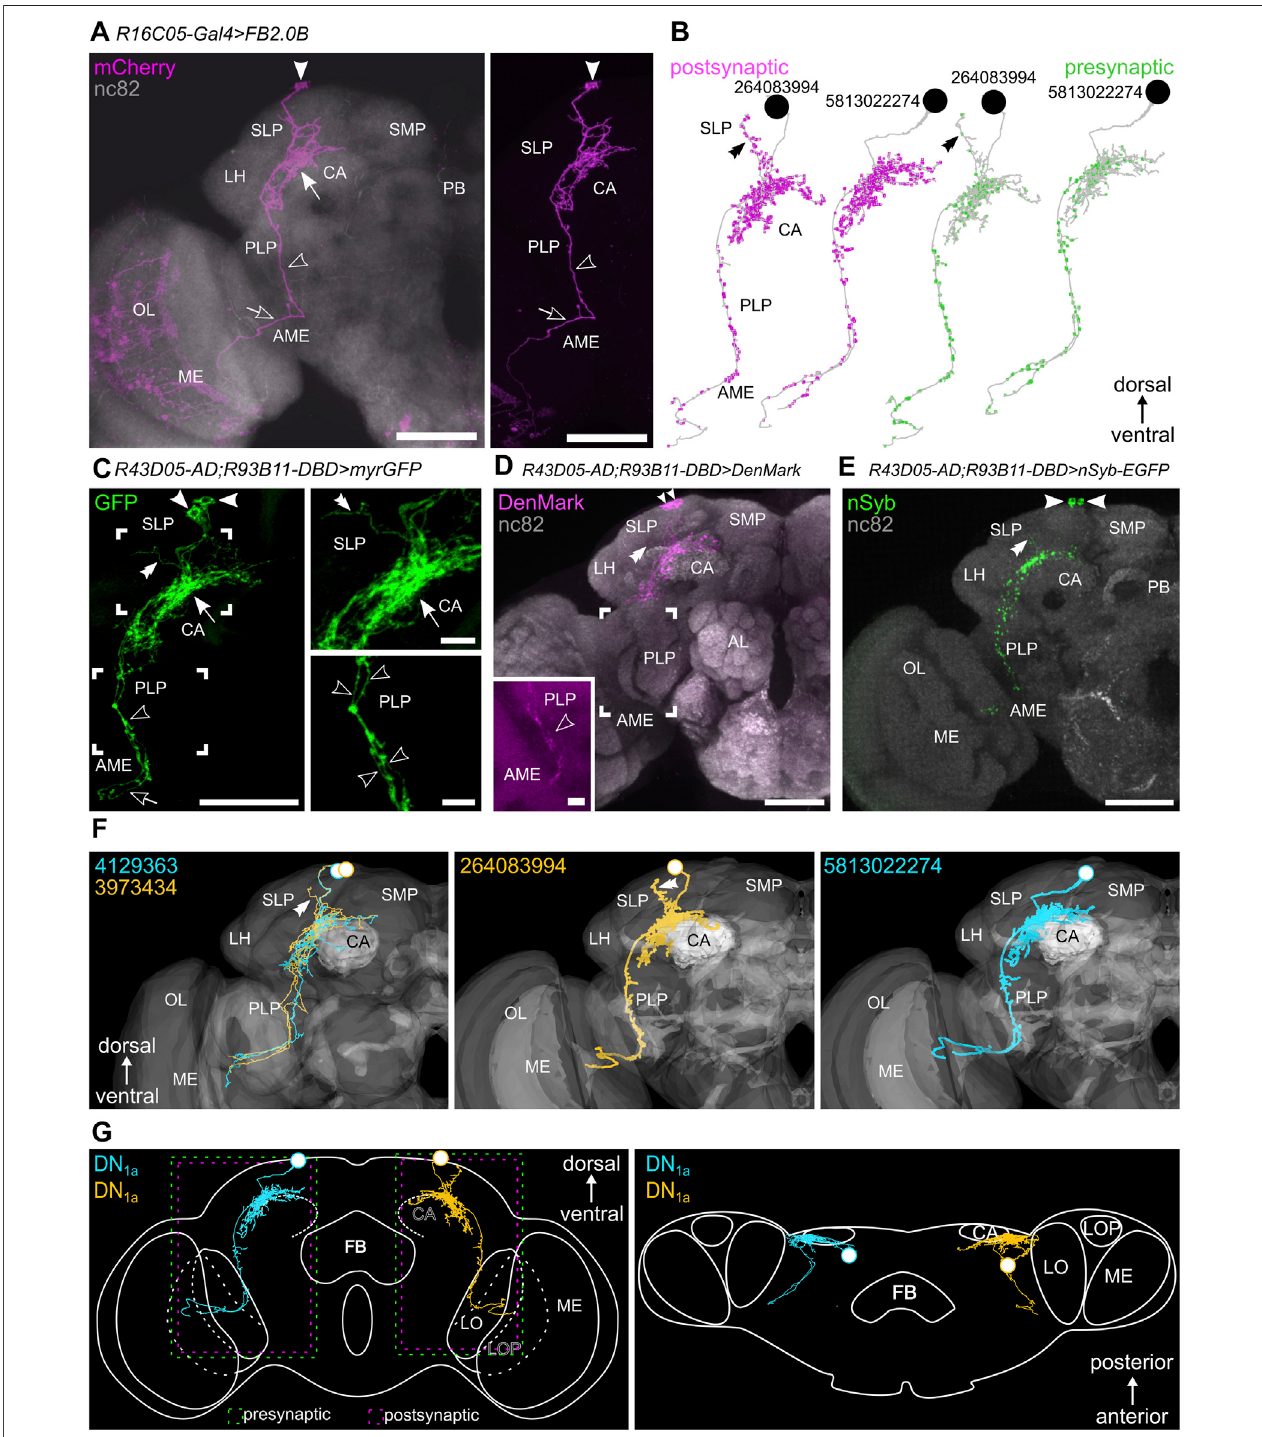
FIGURE 2 | The morphology of the two DN 1a s. (A) Flybow-reporter expression (mCherrry, magenta) driven by R16C05-GAL4 and anti-nc82 neuropil staining (gray).Only oneofthe twoDN 1a sislabeled togetherwith severalsmallcellsin theoptic lobe.A single fi ber ofthisneuronprojects from theSLP throughthe ventromedial lateral horn (LH) and the posterior lateral protocerebrum (PLP) into the accessory medulla (AME) and further toward the surface of the medulla (ME) (open arrow). The arrow pointstoitsdensearborizationsaroundthemushroombodycalyx(CA). (B) Postsynaptic(magenta)andpresynaptic(green)sitesofthetwoDN 1a s(revealed in the hemibrain) are distributed over the entire neurons. (C) Morphology of both DN 1a s visualized in the highly DN 1a speci fi c split-GAL4 linewith membrane-bound GFP (maximal projection of 47 confocal planes). Both DN 1a s project to the AME (open arrow and arrowhead) and only differ by a faint anteriorly projecting fi ber in the SLP